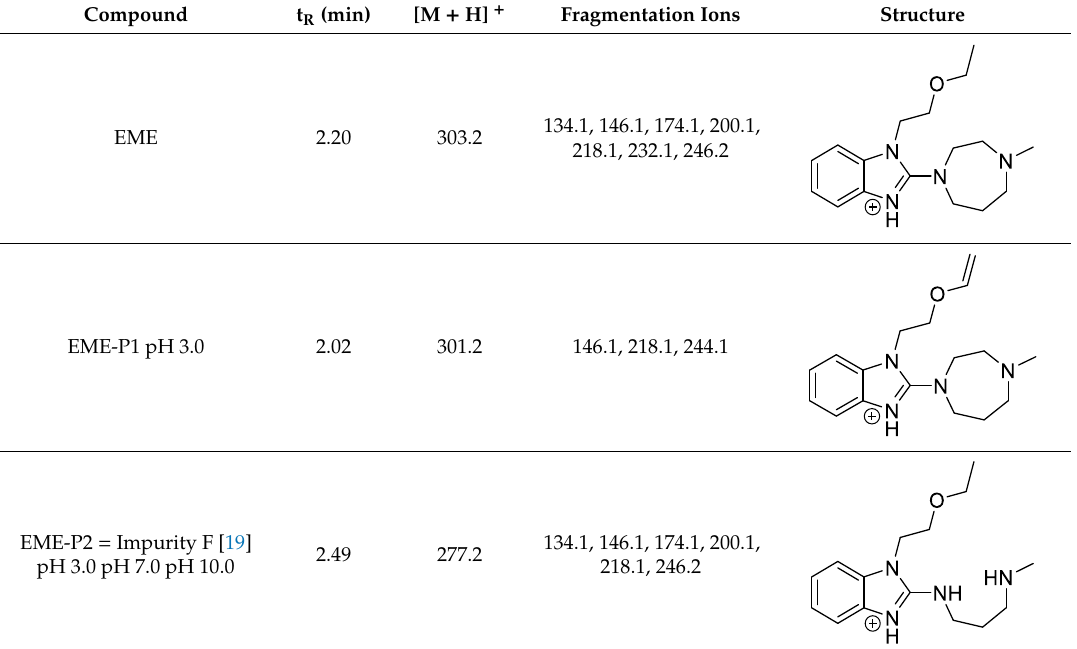
Table 3. Proposed structures of the photodegradation products of emedastine (EME). Compound